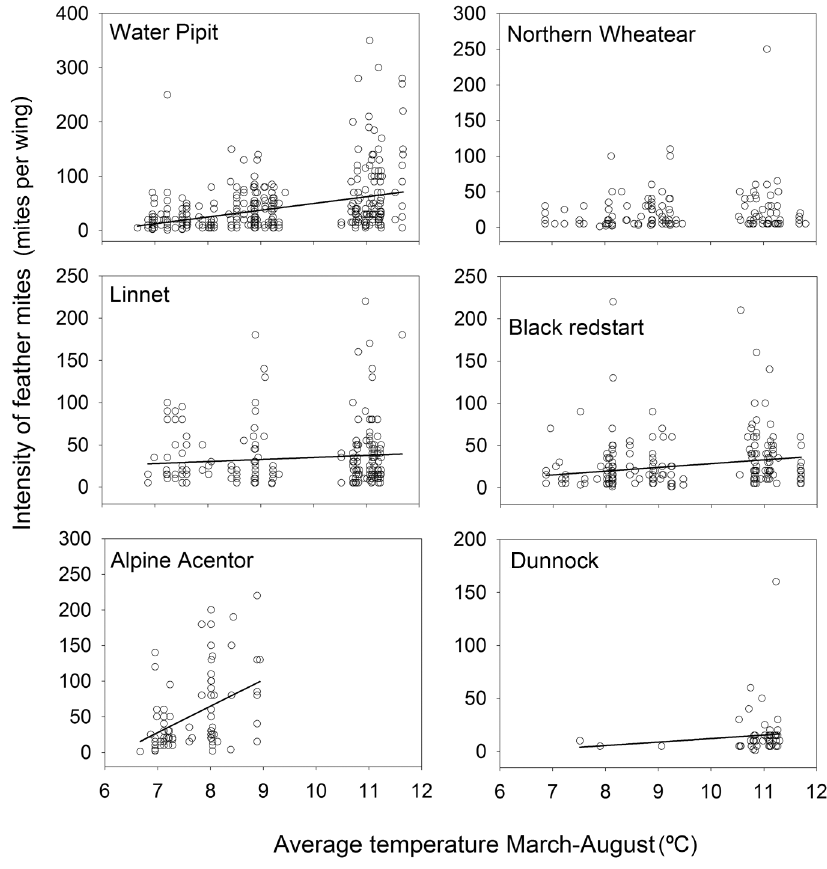
Figure 4. Feather mite intensity and temperature. Relationship between average mite intensity and average temperature (March-August) of the six bird species analyzed. The trend line is shown when the relationship was significant.